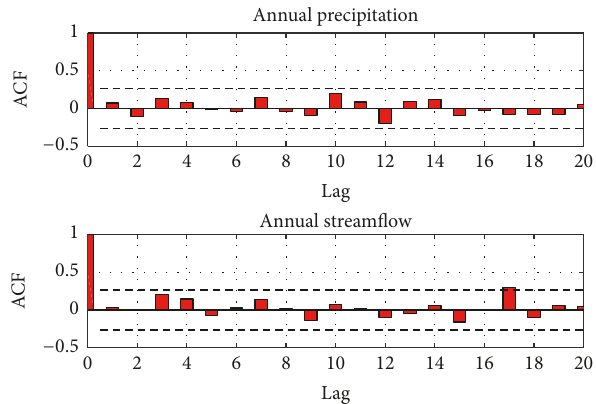
Figure 3: Autocorrelation analysis of meteor-hydrological series of the Yi River Basin. The dashed lines denote 95% confidence level (ACF means autocorrelation